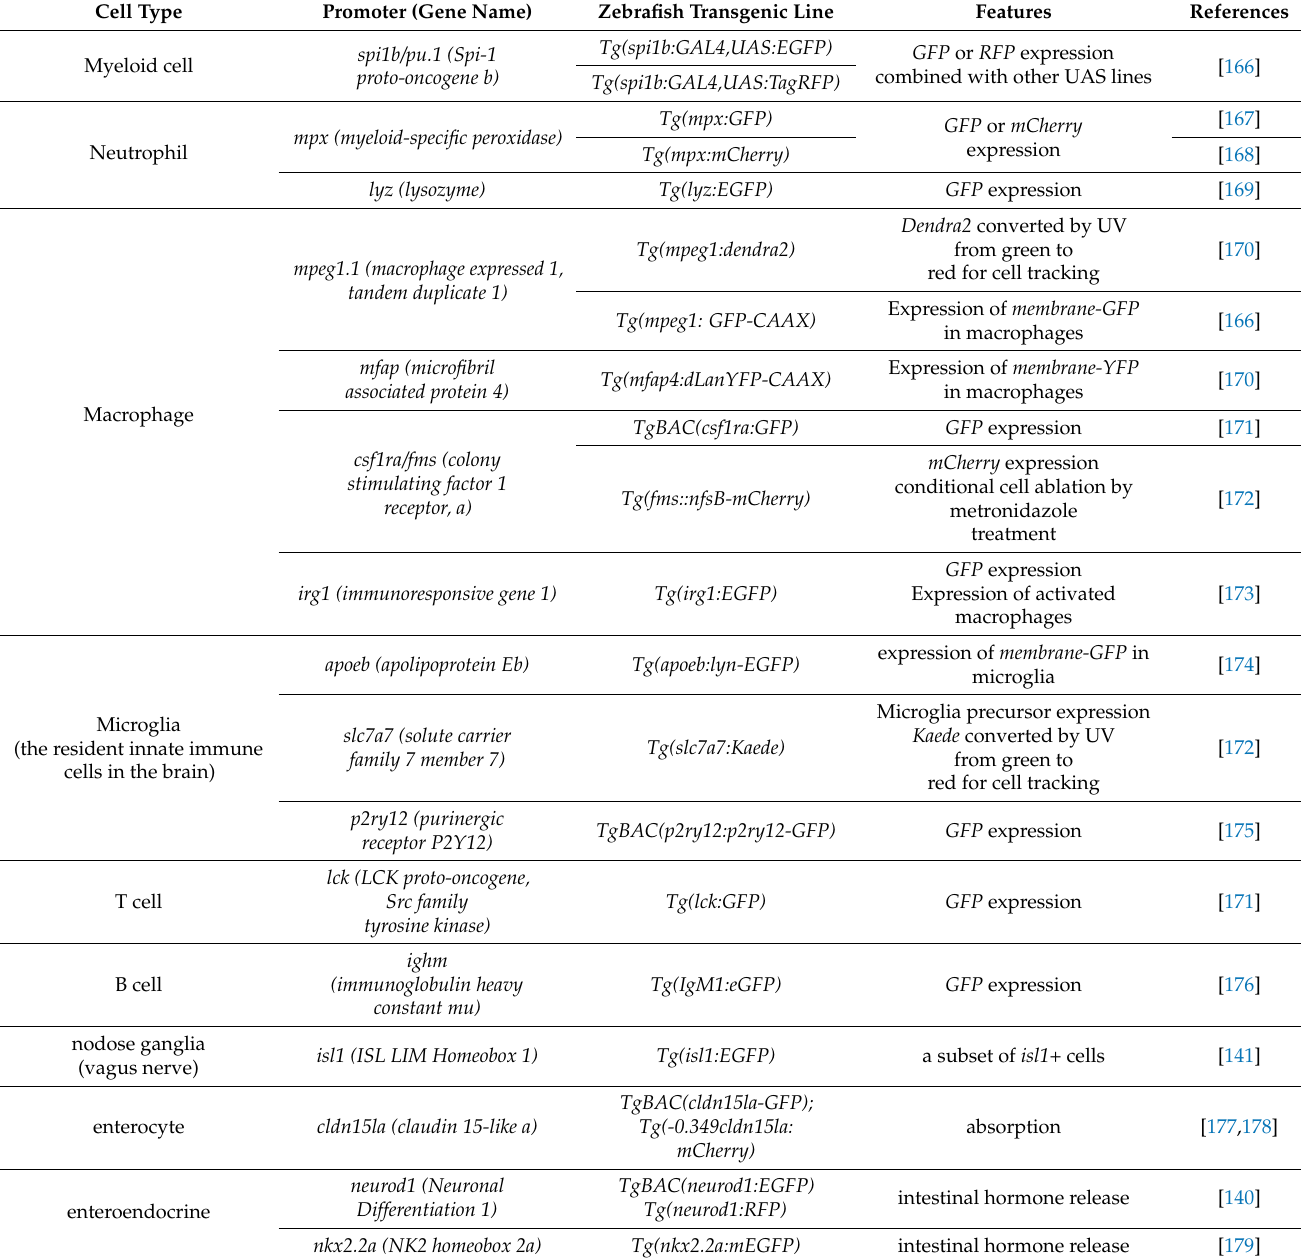
Table 1. Zebrafish transgenic reporter lines labeling various immune cell